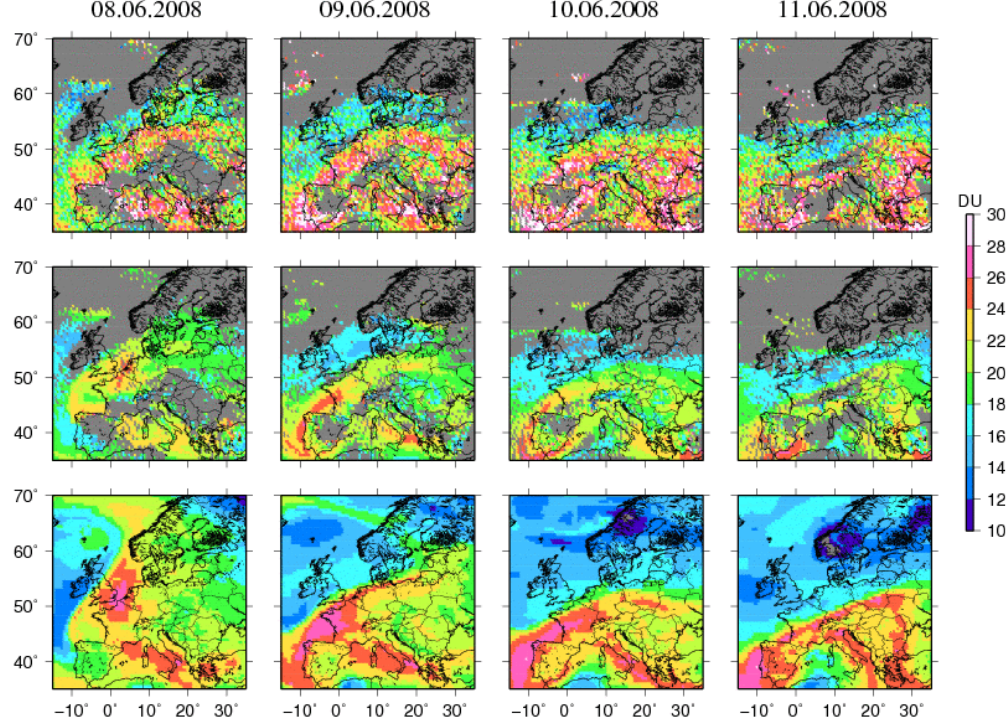
Fig. 8. Time evolution of 0–6km ozone partial columns (in Dobson Units) as observed by IASI (upper panel), and simulated by models for the 8 to 11 June 2008 period. The median value over all participating models is taken. For models both smoothed (middle panel) and raw (lower panel) columns are